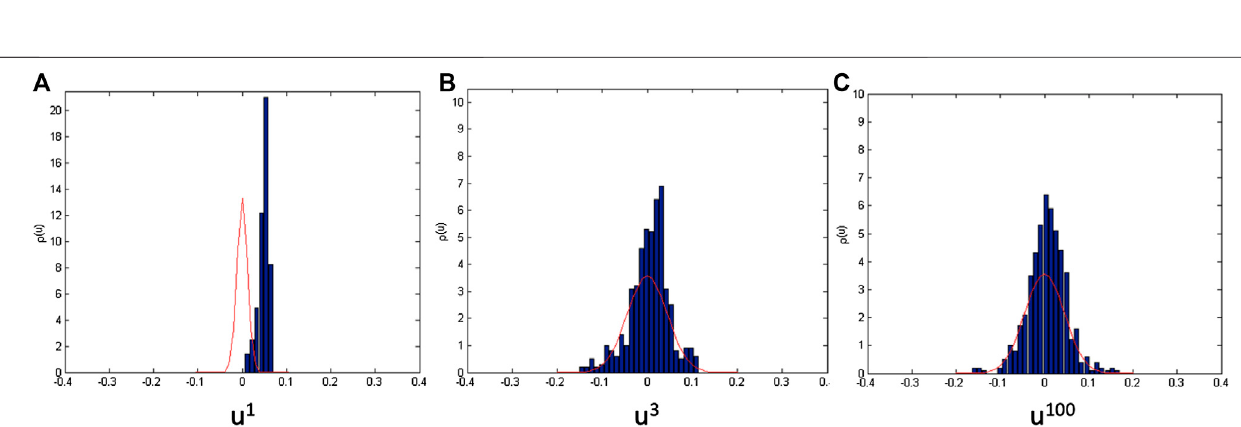
FIGURE 5 | Comparison among the distribution of eigenvector components. For example, (A) is the largest u 1 , (B) is the third largest u 3 , and (C) is the hundredth largest u 100 .Thebluecolorrepresentsthedistributionofthe C matrix,andtheredonerepresentsthedistributionofthe R matrixintheS&P500dailysharepricedatafor the period of January 1, 2007 until October 28,